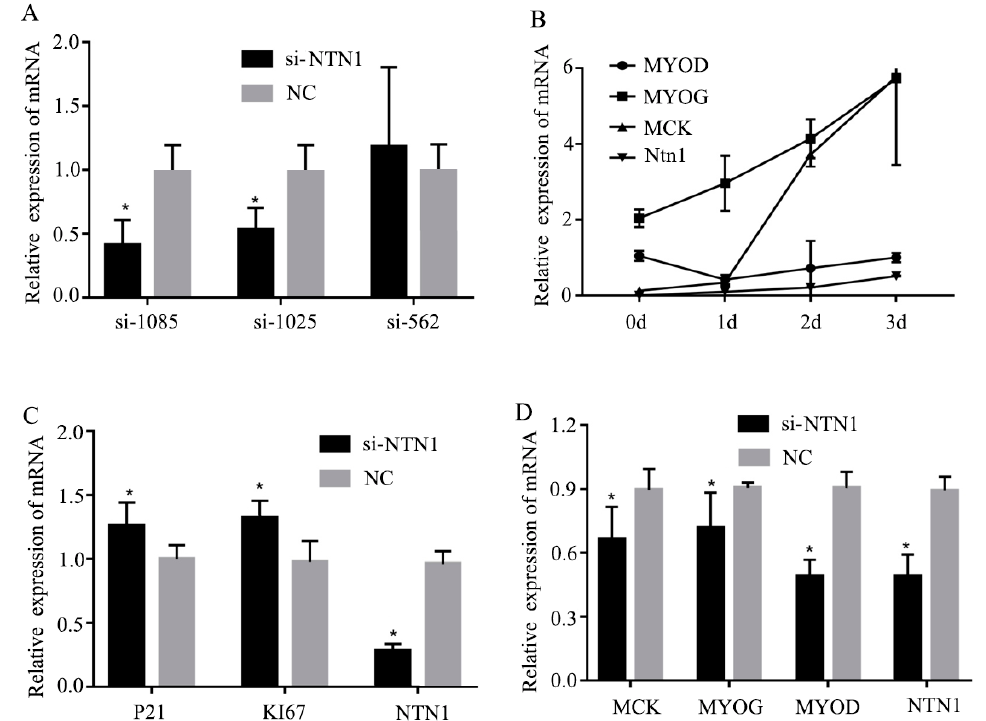
Figure 2. Effect of si- NTN1 on the proliferation and differentiation of C2C12 cells. ( A ) The interference efficiency of three NTN1 si-RNAs. ( B ) Expression of NTN1, antigen identified by monoclonal antibody Ki 67 (KI67) , and cyclin-dependent kinase inhibitor ( P21 ) gene in C2C12 cell proliferation phase. ( C ) The expression levels of NTN1 and muscle creatine kinase ( MCK ) , myogenin ( MYOG ) and class I myosin ( MYOD ) in normal differentiation C2C12 cells. ( D ) Expression of muscle creatine kinase ( MCK ), MYOG , MYOD , and NTN1 gene in C2C12 cell differentiation phase. The results were represented as mean ± SD. The expression level of genes in si- NTN1 C2C12 cells was determined by q-PCR using NC as the control. * p < 0.05.